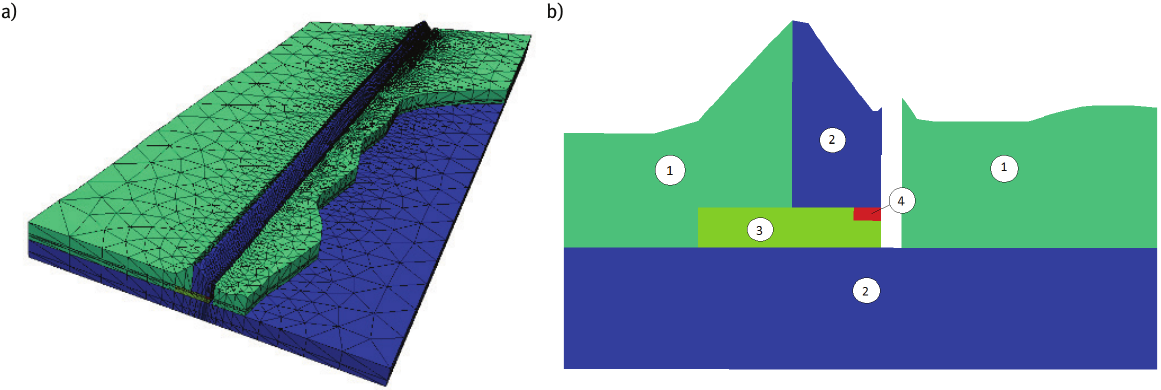
Figure 13: Comparison of water table height (in the case of no drainage) for both variants of diaphragm wall length. Longer diaphragm wall on the left, shorter on the